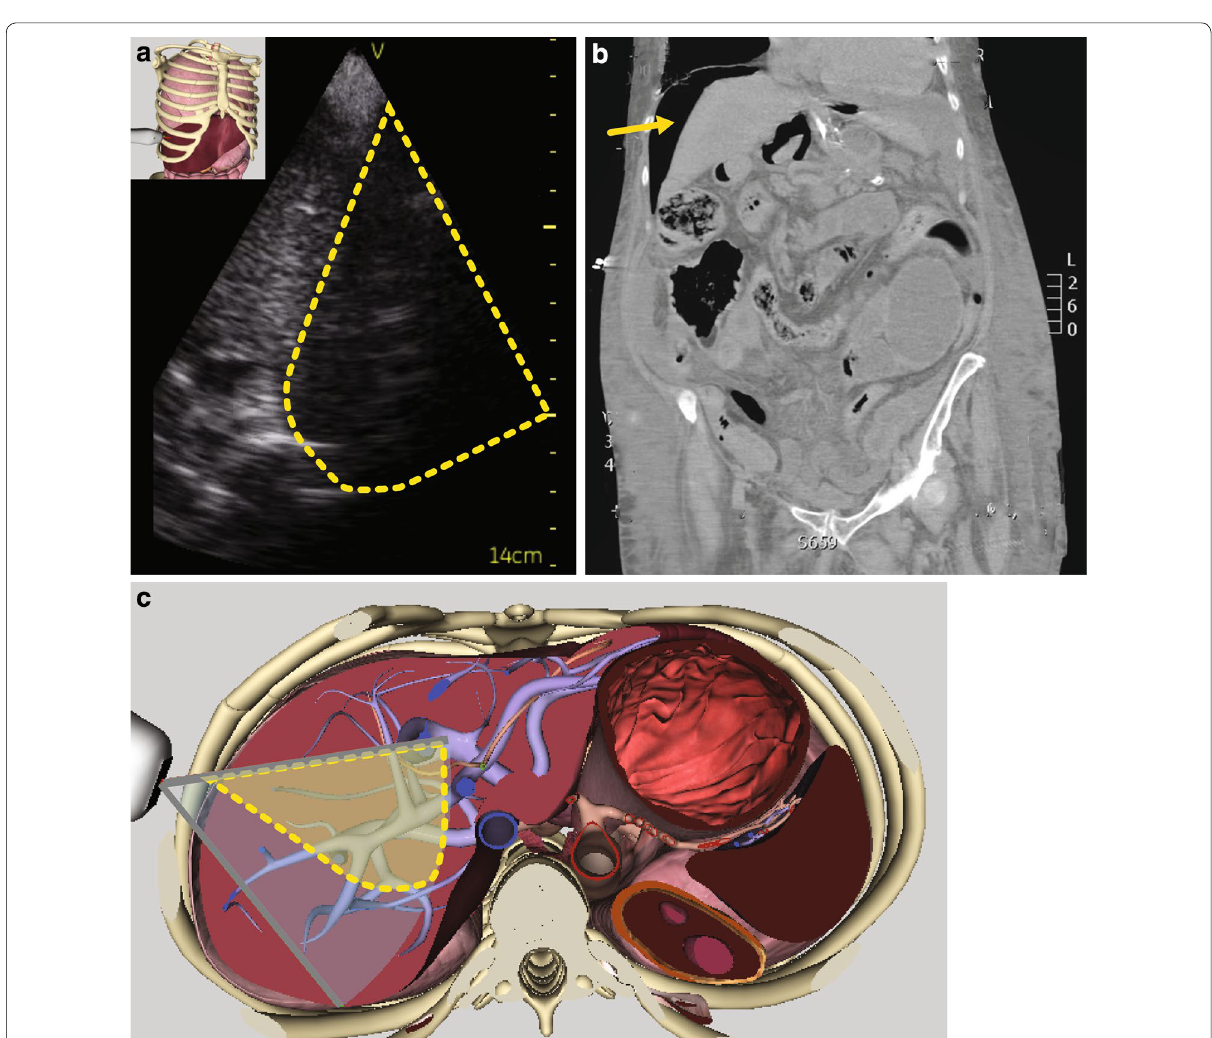
Fig. 4 a Mid‑axillary transhepatic transverse view of the liver in a patient with acute pneumoperitoneum. Note the acoustic shadowing in the right-sided portion of the liver which corresponds to the most anterior part of the liver where air will accumulate. b Confirmation was obtained with computed tomography. c Corresponding anatomical plane using the Vimedix simulator (CAE Healthcare, Ville St‑Laurent, QC, Canada). (See Additional file 4: Video